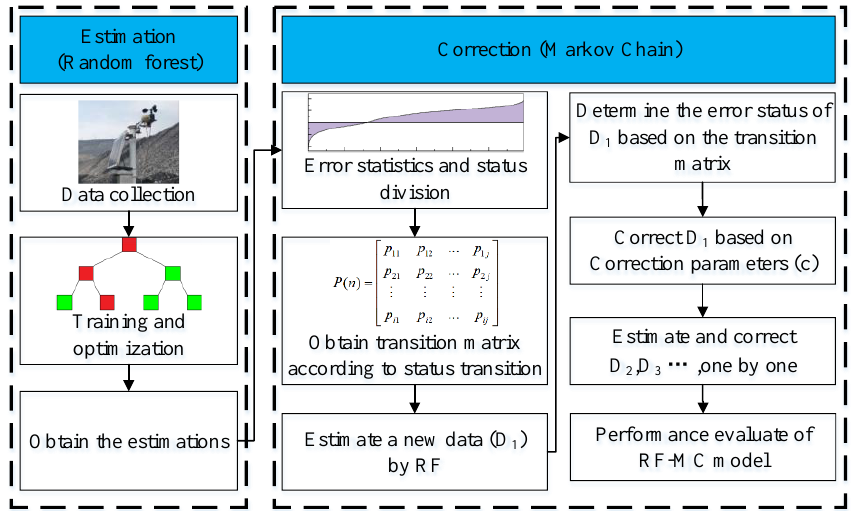
Figure 4. The overall flow for the RF-MC model.